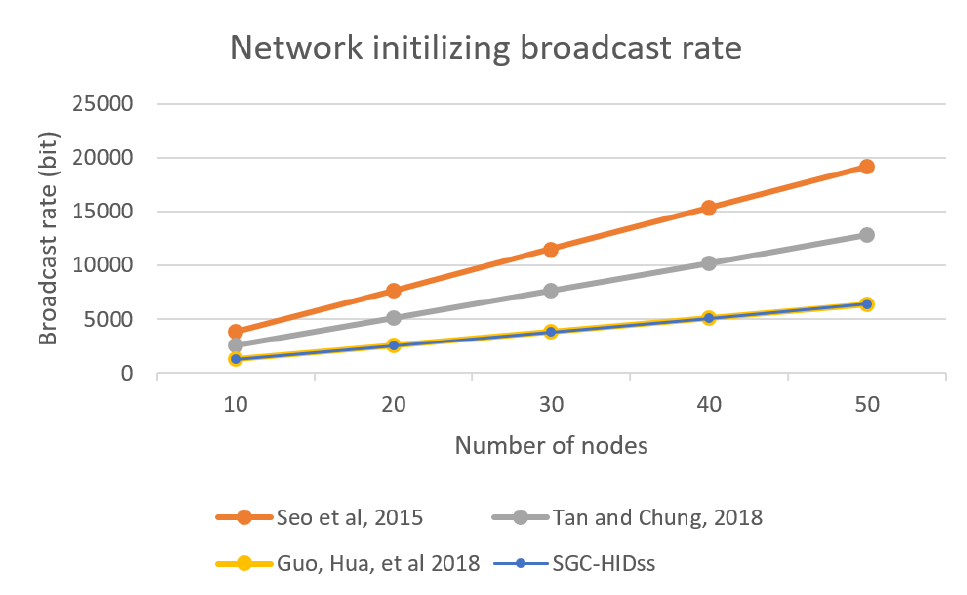
Figure 7. BS broadcast rate for initializing the group.